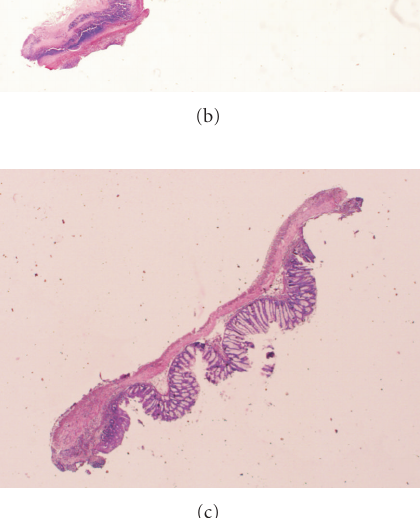
and submucosa (up to 50% of colon section). The samples from mice treated with 0.2% thyme and 0.1% oregano oils (B) show intermediary histopathological changes (up to 30% of colon section).